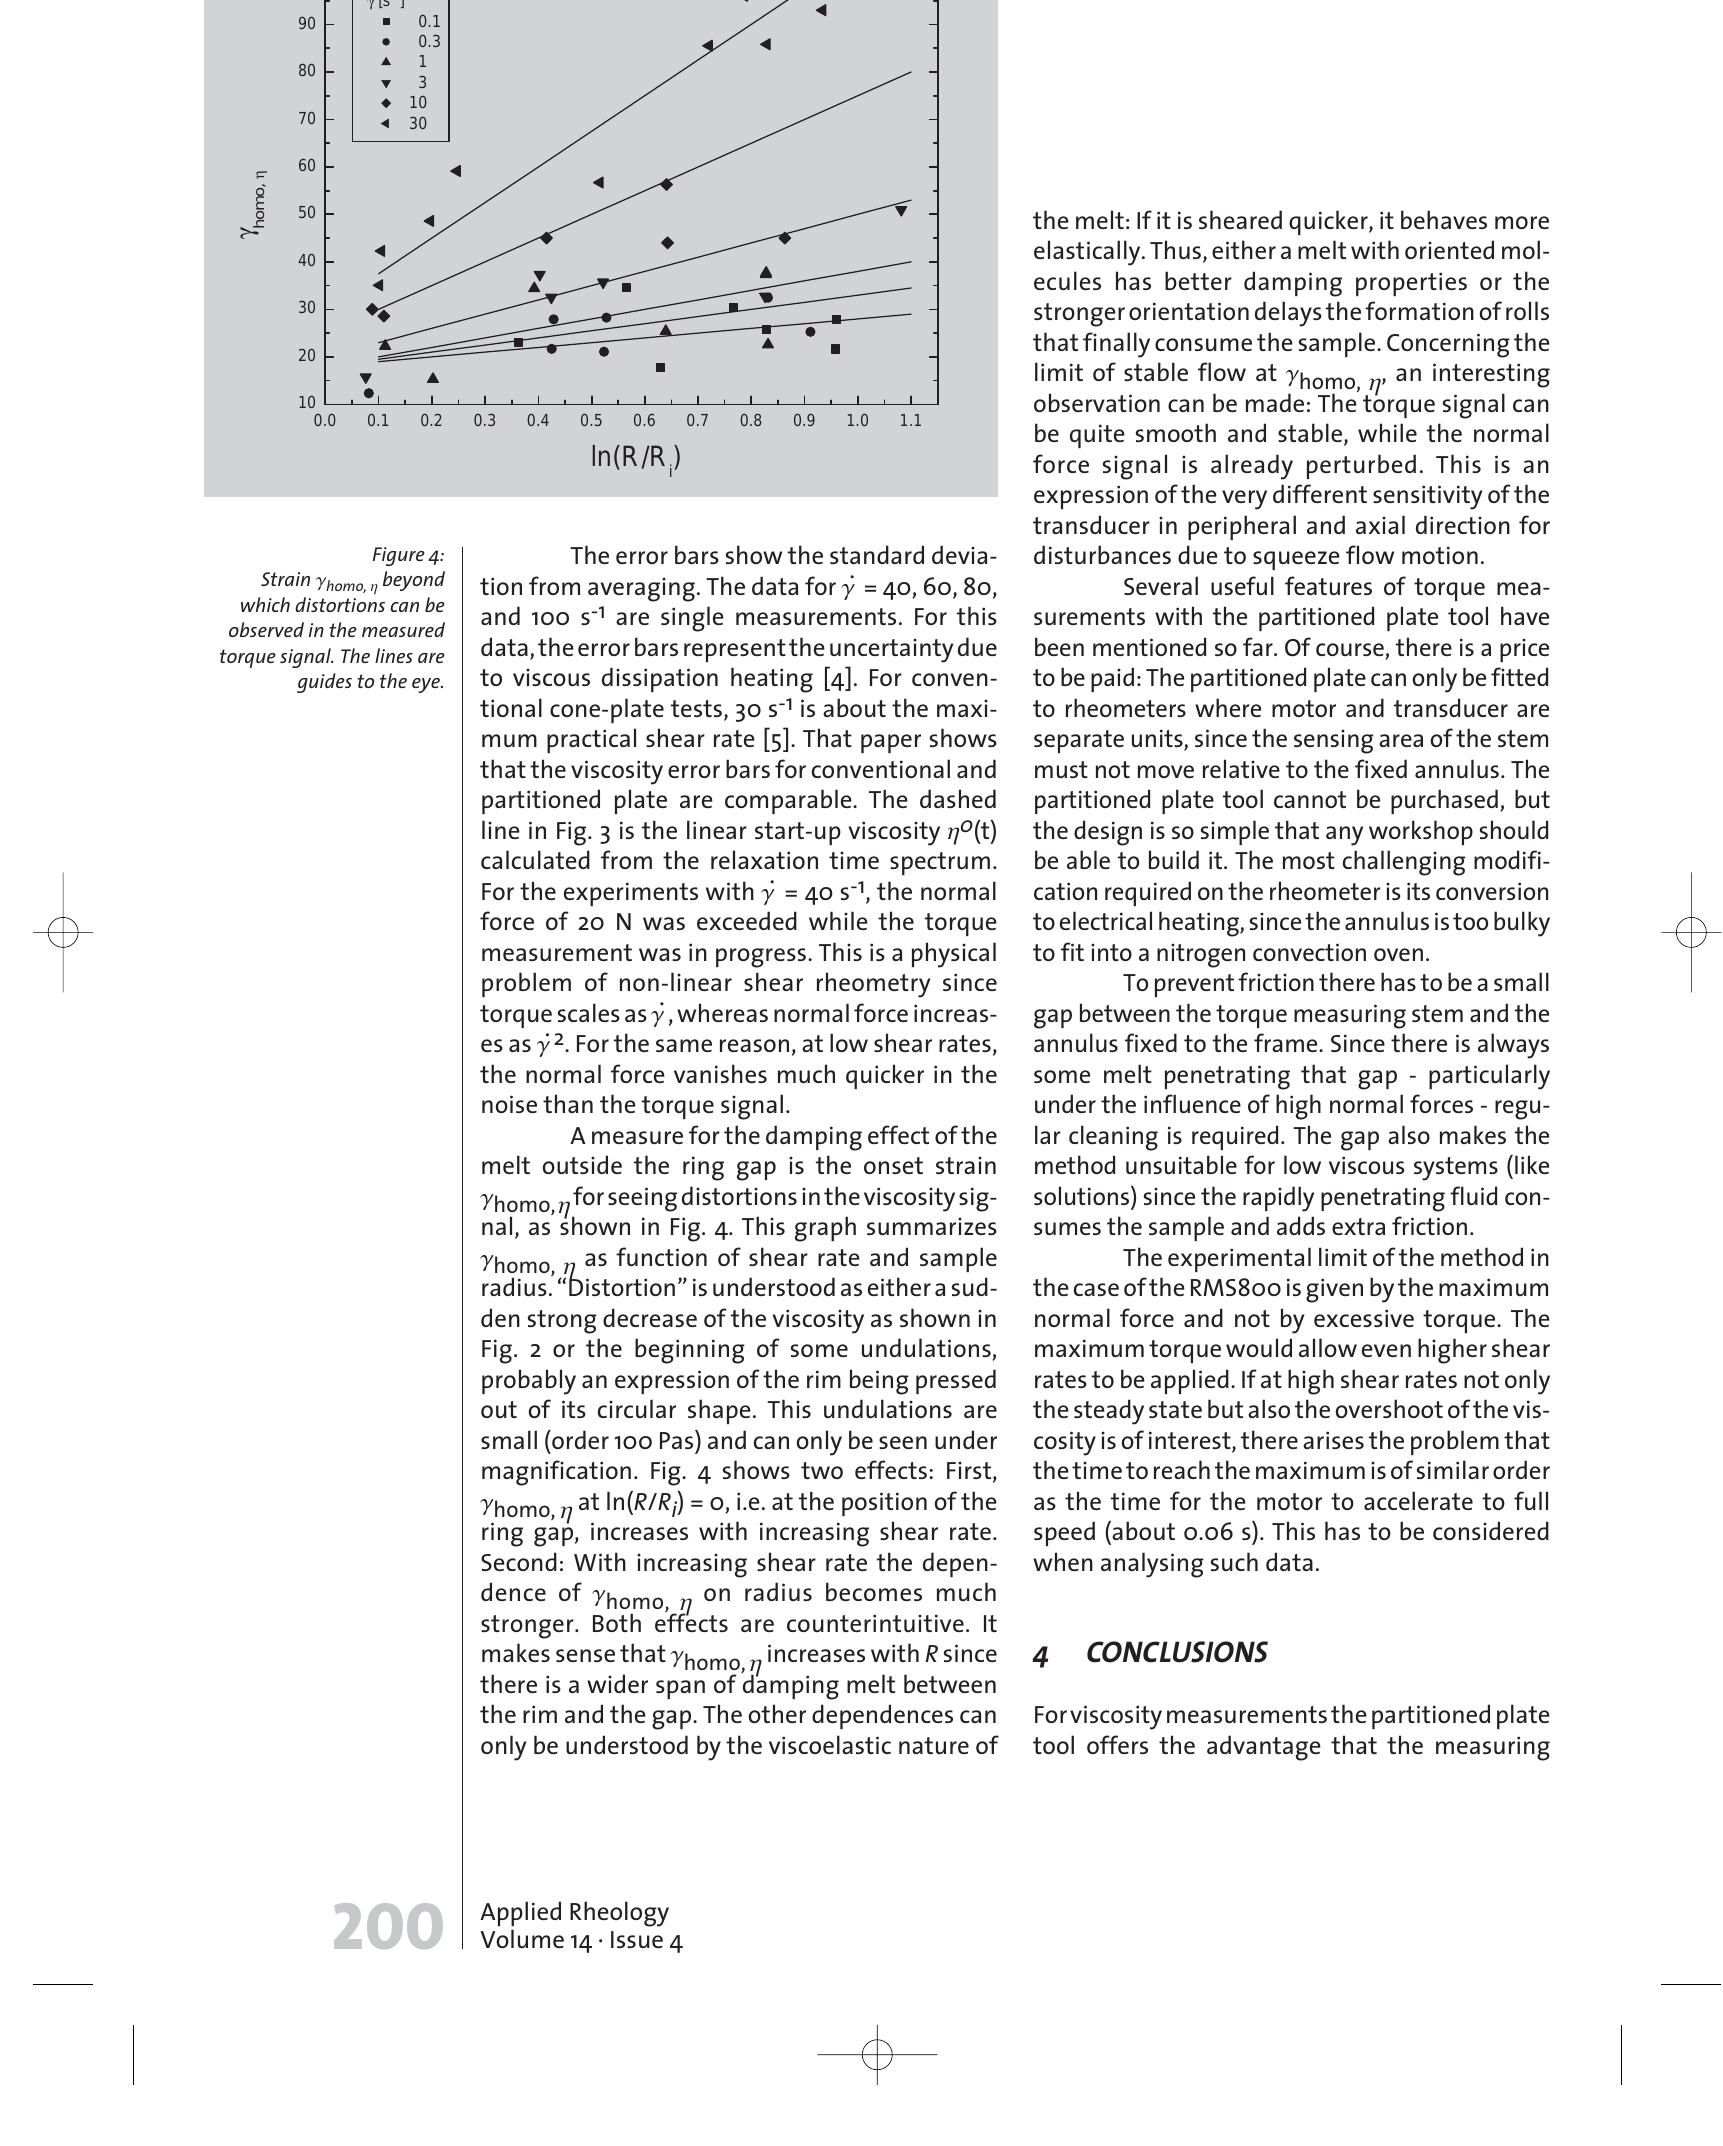
error bars show the standard devia- Figure 4: · Strain g homo, h beyond tion from averaging. The data for g = 40, 60, 80, which distortions can be and 100 s -1 are single measurements. For this observed in the measured data, the error bars represent the uncertainty due torque signal. The lines are to viscous dissipation heating [4]. For conven- guides to the tional cone-plate tests, 30 s -1 is about the maxi- mum practical shear rate [5]. That paper shows that the viscosity error bars for conventional and partitioned plate are comparable. The dashed line in Fig. 3 is the linear start-up viscosity h 0 (t) calculated from the relaxation time spectrum.